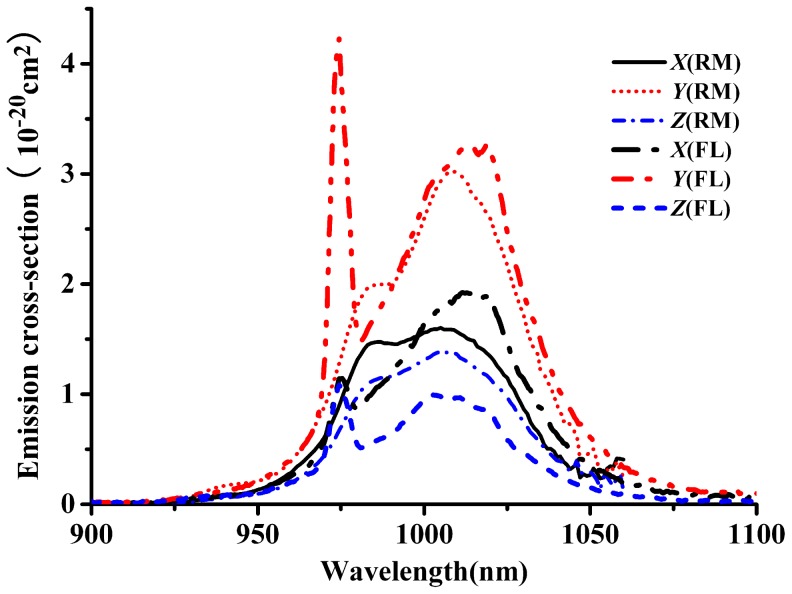
Emission cross-section of Yb3+ in KBaGd(MoO4)3 crystal calculated by the RM and F-L methods.